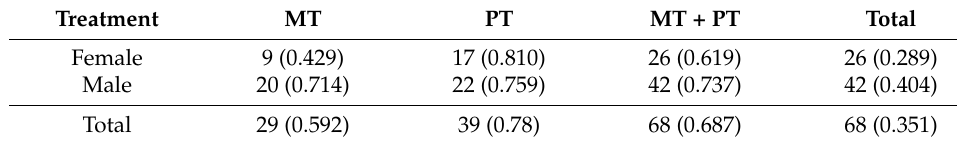
Table 2. Number (Proportion) of subjects lying in the first